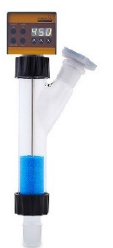
Figure 10. Hi-Doser 0.2l, powder-dosing instrument.